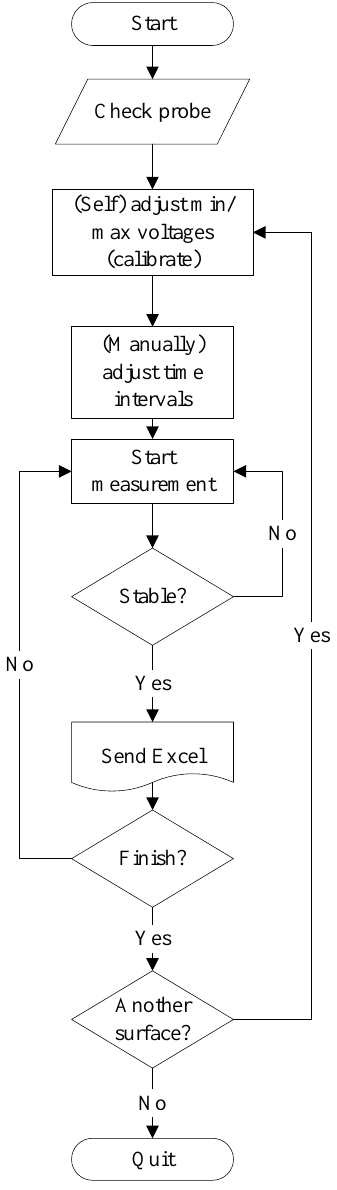
Figure 4. Flowchart of the measurement procedure.